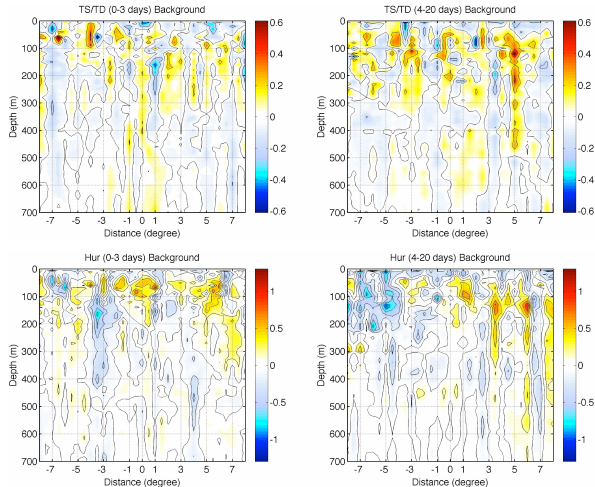
Figure B4. Background ocean thermal changes as a function of depth and distance in TC-track coordinates. The background foot- print is created corresponding to a TS/TD footprint (a) on a 0–3-day average and (b) on a 4–20-day average, and to a hurricane footprint (c) on a 0–3-day average and (d) on a 4–20-day average. The con- tour interval is 0.2 ◦ C in black. The units are ◦ C.